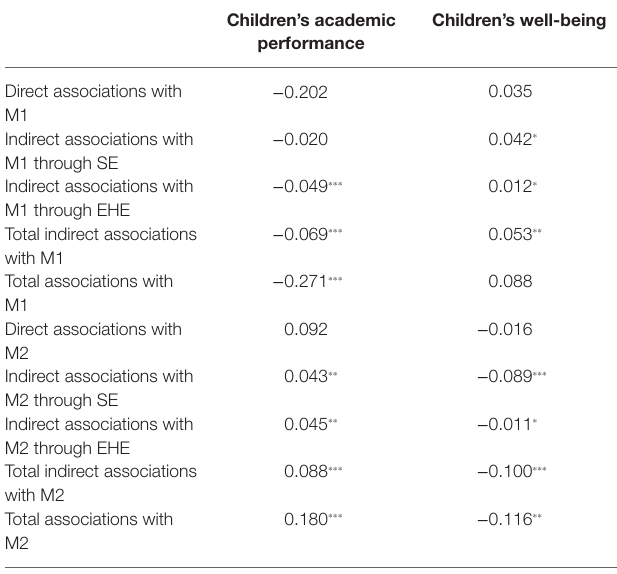
TABLE 6 | Standardized direct, indirect, and total associations based on the whole study sample in Study 2.